Question: Which visualization type does this figure use?
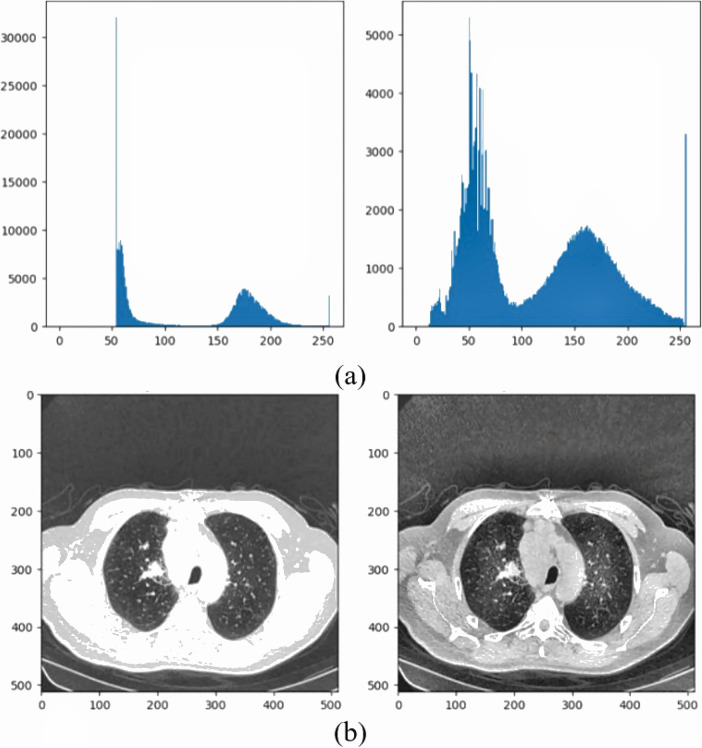
Answer: histogram